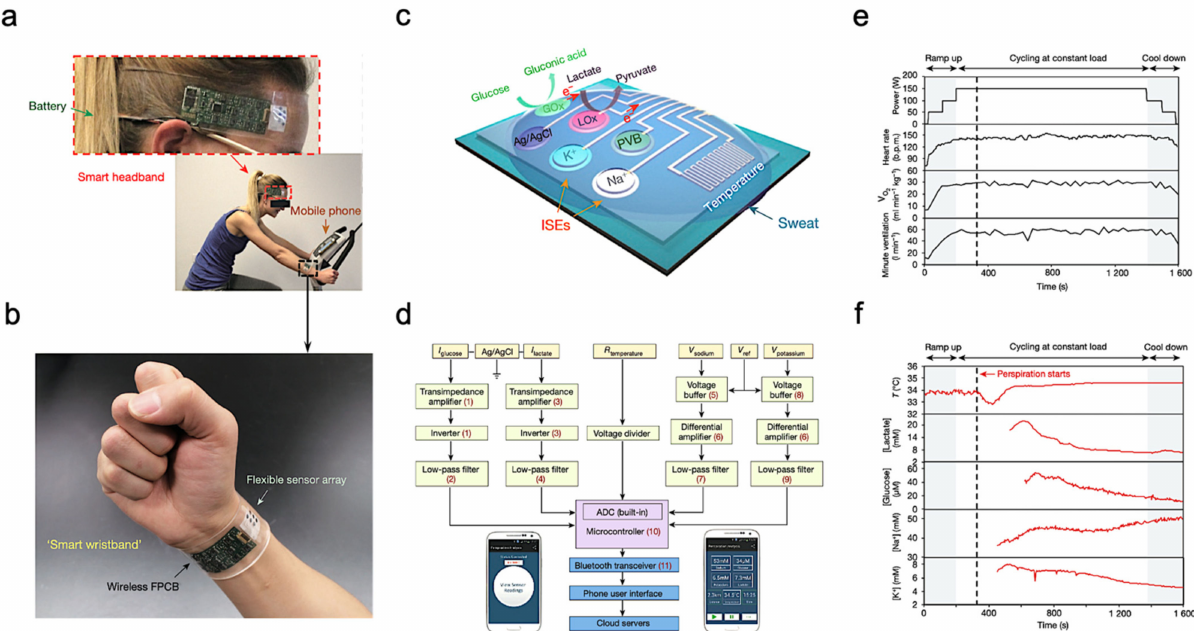
Figure 5. Sweat-based sensors for exercise monitoring. ( a ) Subject wearing forehead and wrist sensors undergoing stationary exercise. ( b ) Flexible integrated sensor array shown on a subject’s wrist as part of a wireless FPCB. ( c ) Schematic of the sensor array. ( d ) System-level block diagram illustrating the flow of information. ( e ) Real-time sweat analysis results of the FISA worn on a subject’s forehead. ( f ) Constant-load exercise at 150 W: power output, heart rate (in beats per minute, b.p.m.), oxygen consumption and pulmonary minute ventilation, as measured by external monitoring systems. Reproduced with permission from ref. [44], Copyright from 2016, Nature Publishing